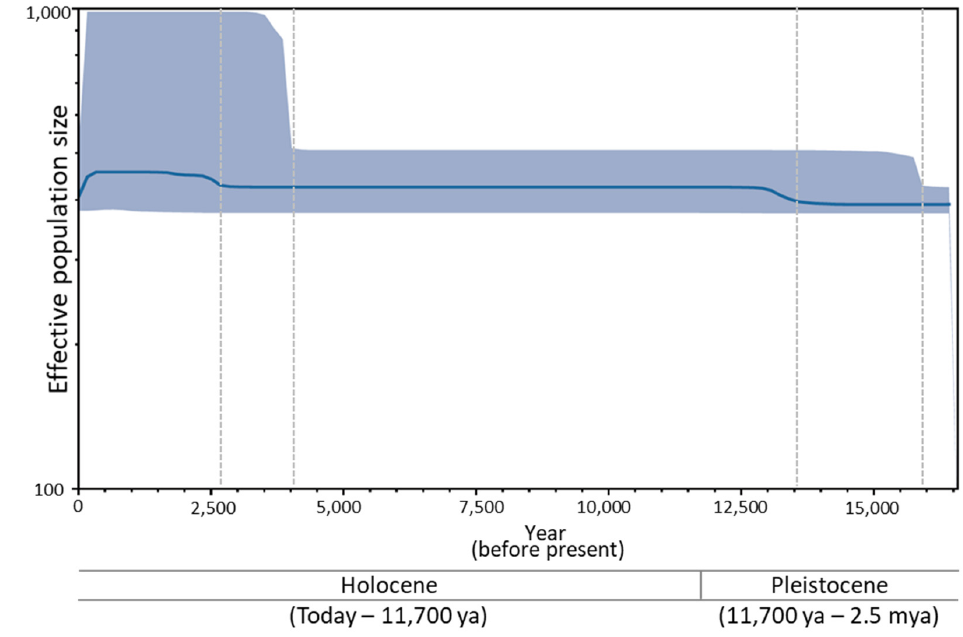
Figure 7. Bayesian skyline plot indicating changes in the effective population size ( Ne ) of Bombyx mandarina over time. The shaded area represents the 95% confidence intervals. The vertical dotted lines represent the potential age of the population expansion.